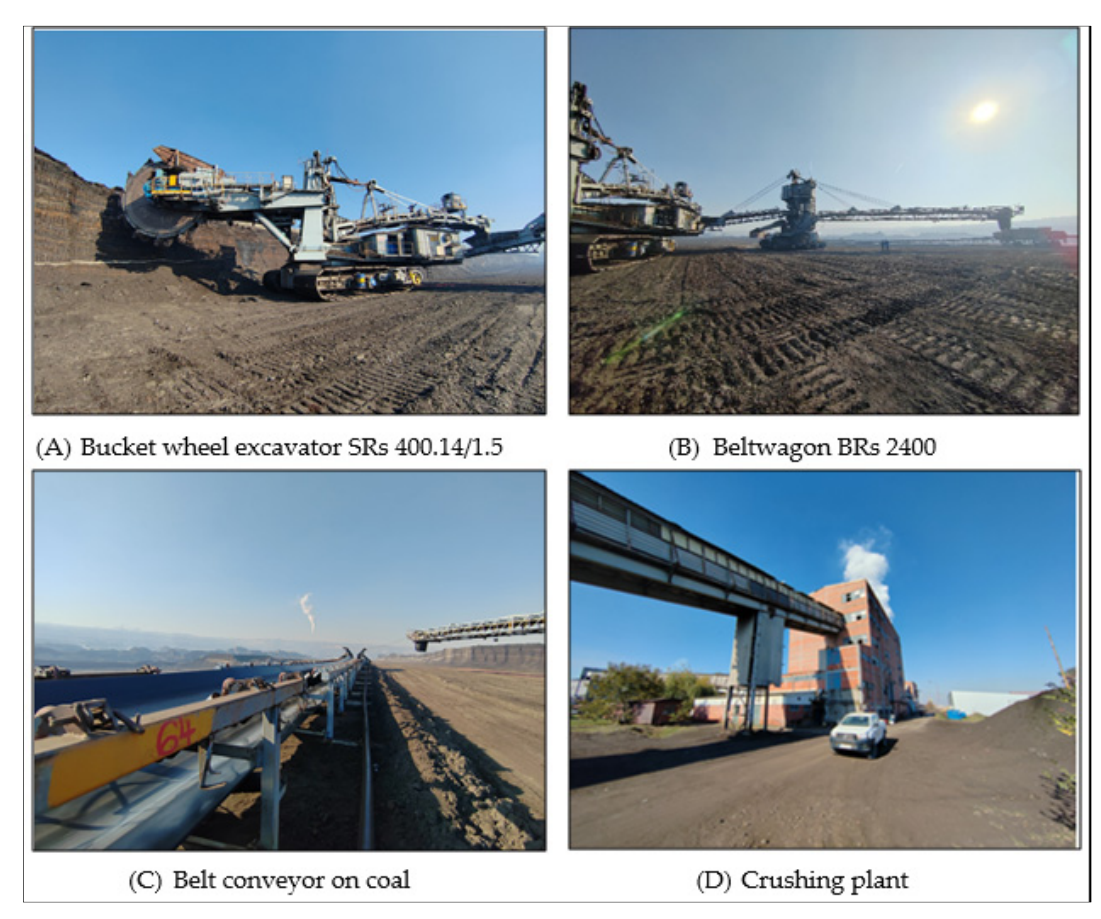
Figure 2. I ECC system at the coal surface mine Drmno Kostolac (photo M. Gomilanovic).